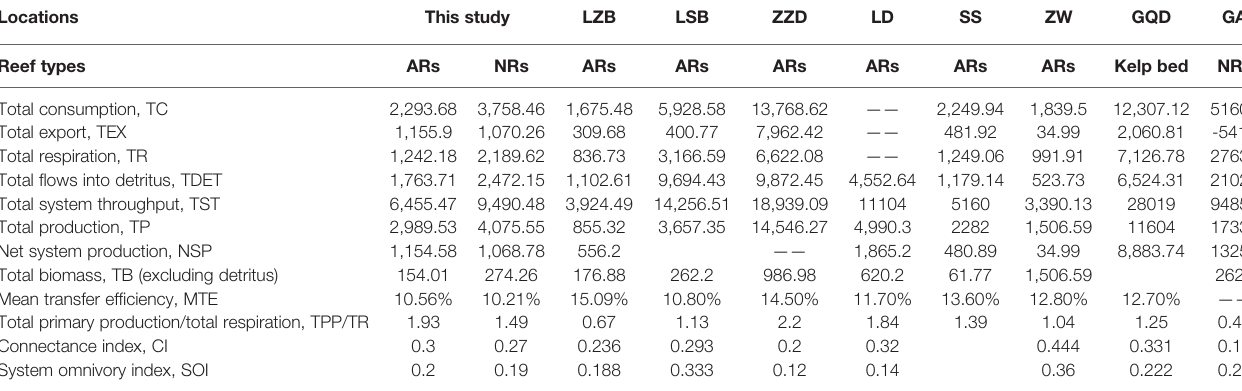
TABLE 4 | Comparisons of ecosystem attributes estimated by balanced Ecopath model between the nearshore arti fi cial reef (AR) and the natural reef (NR) in Yellow Sea, China, and other costal reef areas.